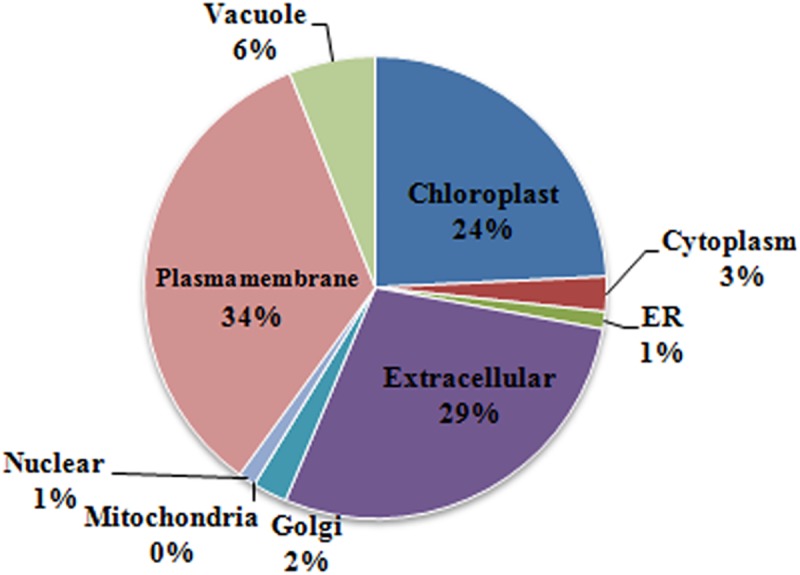
Distribution of glycoproteins in different subcellular compartments.